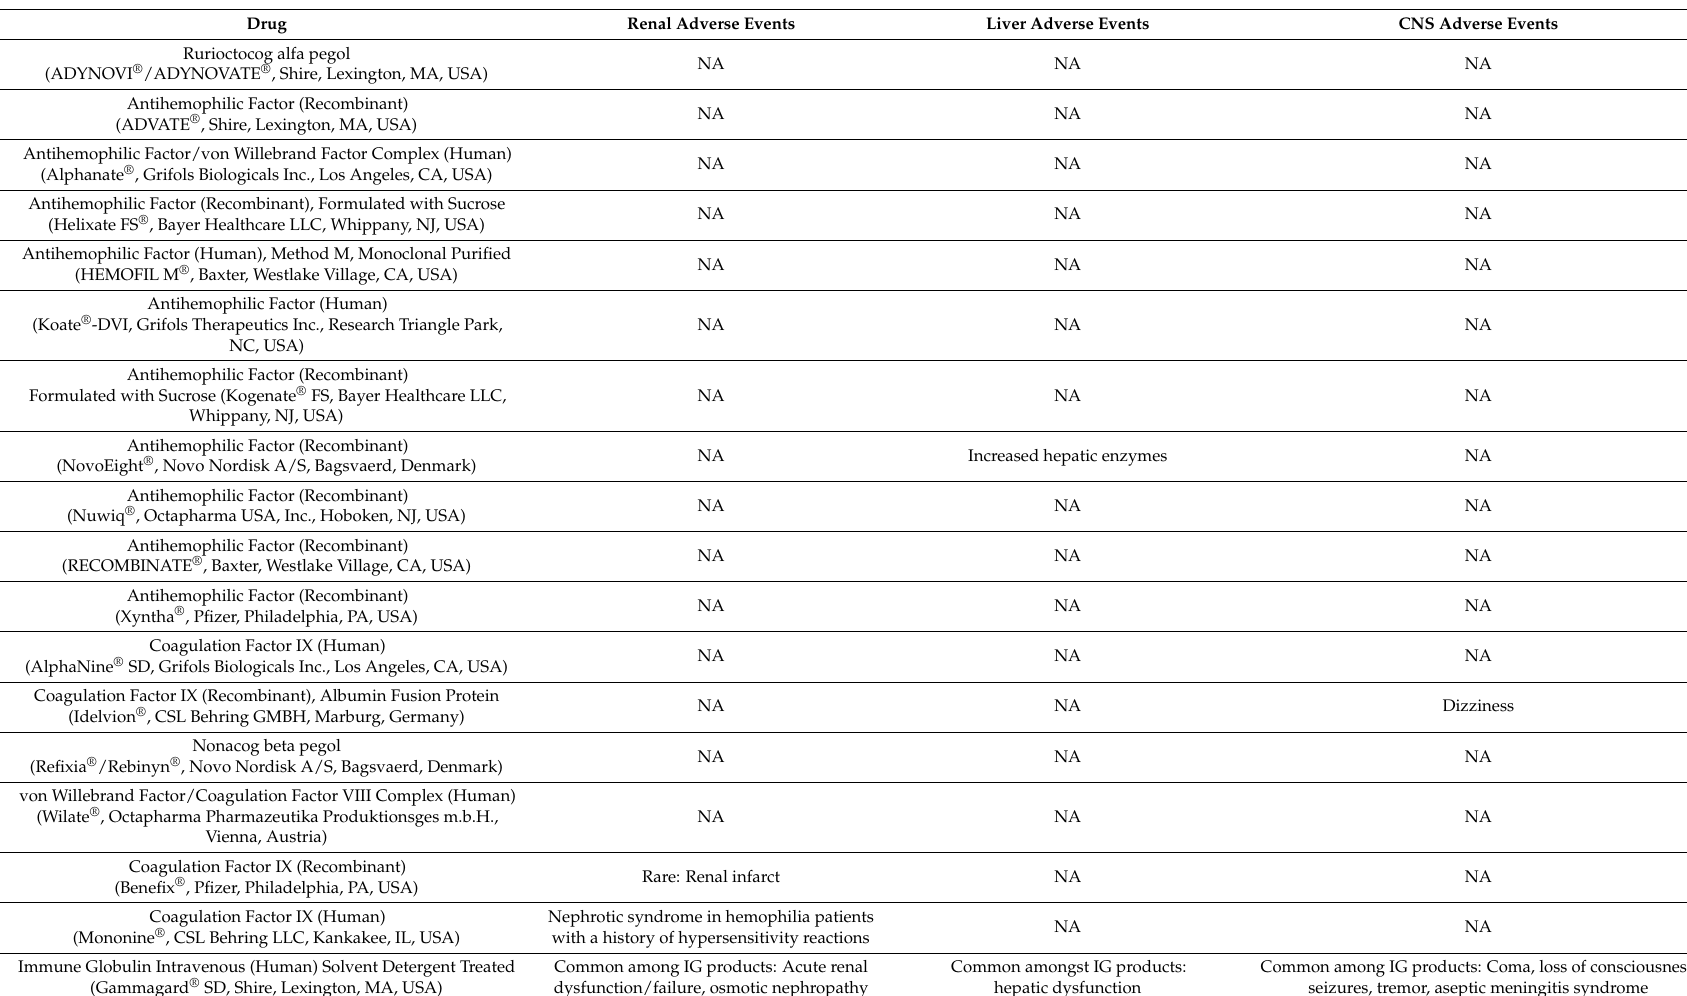
Table 2. Liver, kidney and CNS safety information for the pediatric-indicated therapies sourced from prescribing information, FDA reports and factmed.com. Drug Renal Adverse Events Liver Adverse Events CNS Adverse